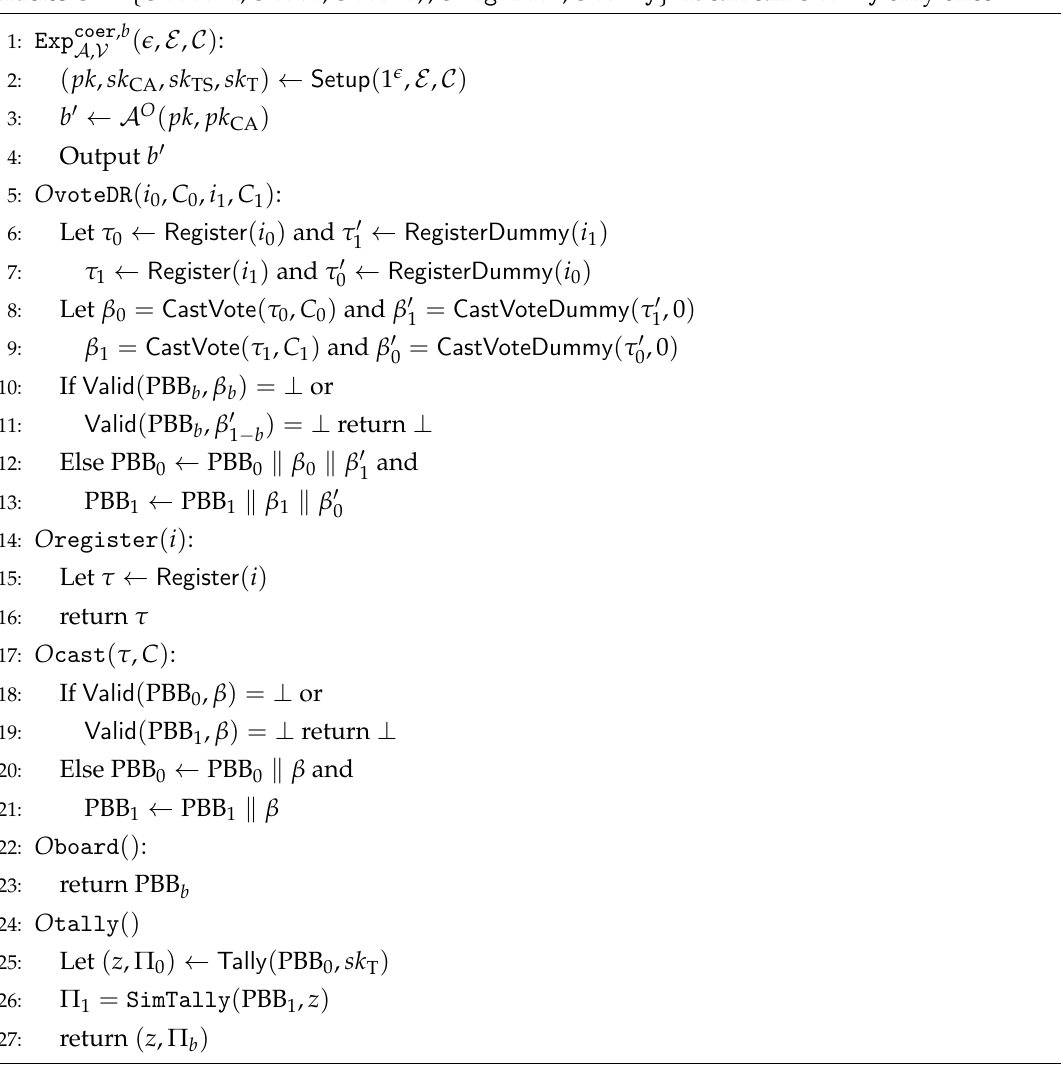
( (cid:101) , E , C ) , adversary A has access A , V